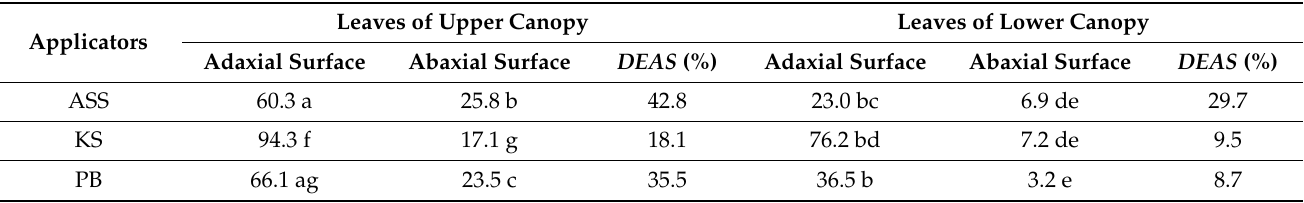
Table 7. Coverage (%) and DEAS values of the three applicators in different parts of the